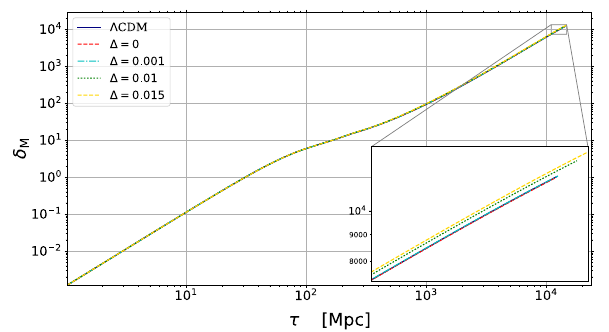
Fig. 3 Hubble parameter in terms of conformal time in Barrow cos- mology compared to (cid:3) CDM